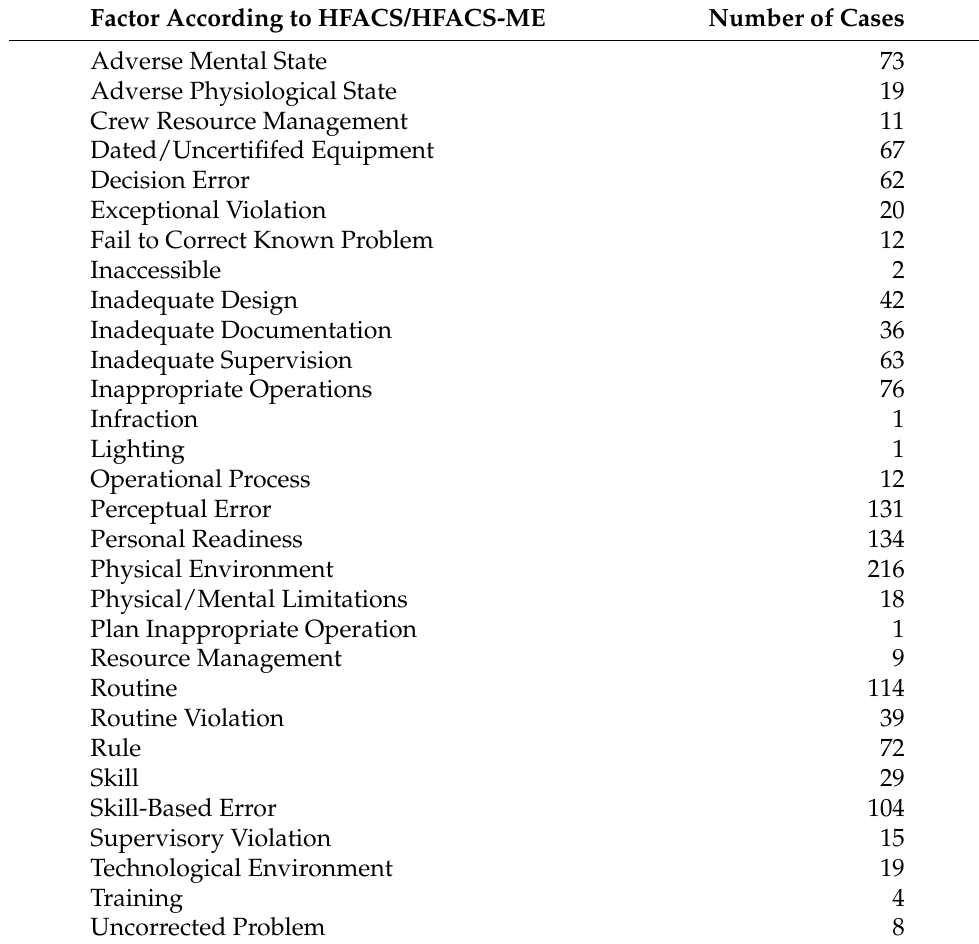
Table 2. The HFACS and HFACS-ME manually labeled from the contributory causes of the database, with their frequency in the